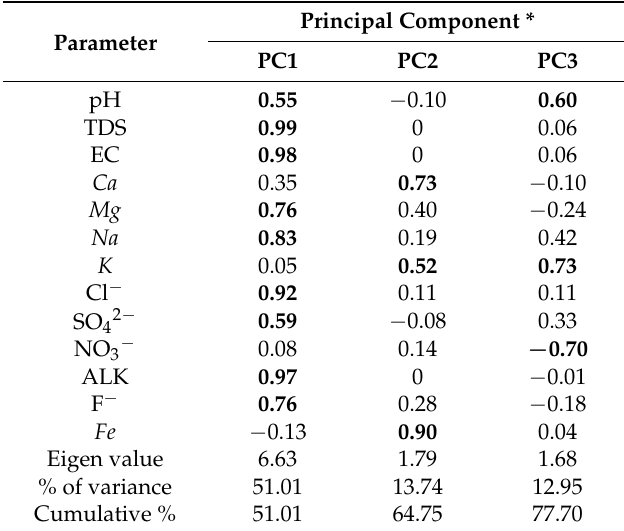
Table 3. Water quality parameters for the 12 bottled water brands. Principal Component * Parameter